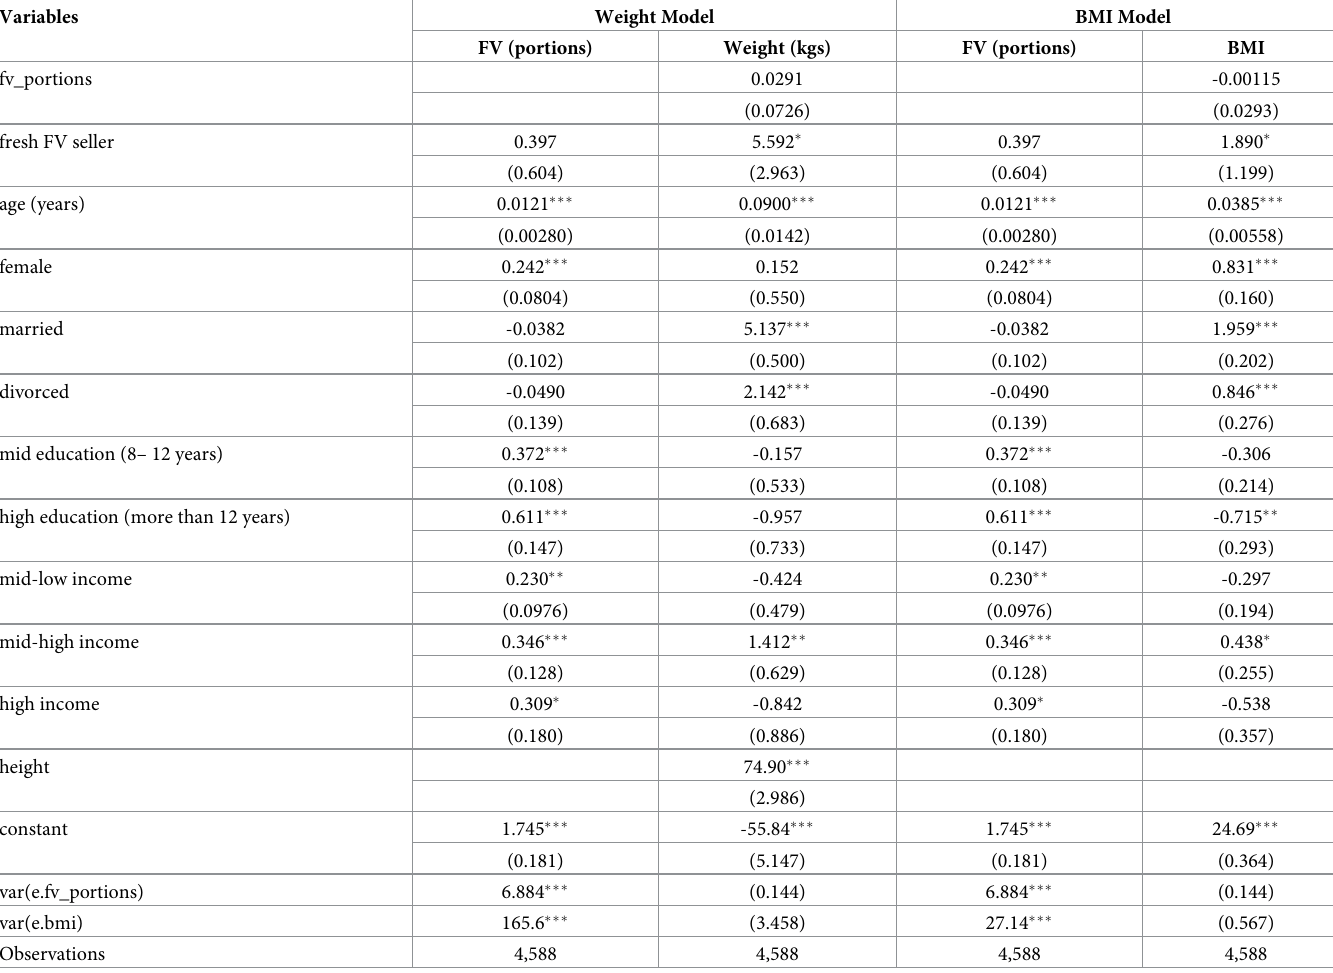
Table 3. Mediation regressions of BMI and